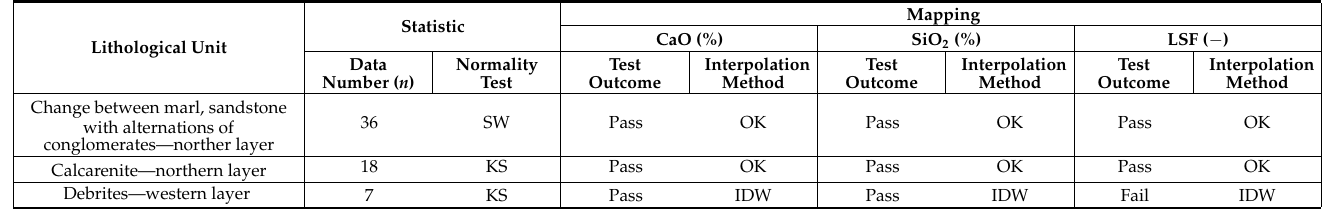
Table 2. Input data, formality tests results, and interpolation methods for units (1), (5), and (7).